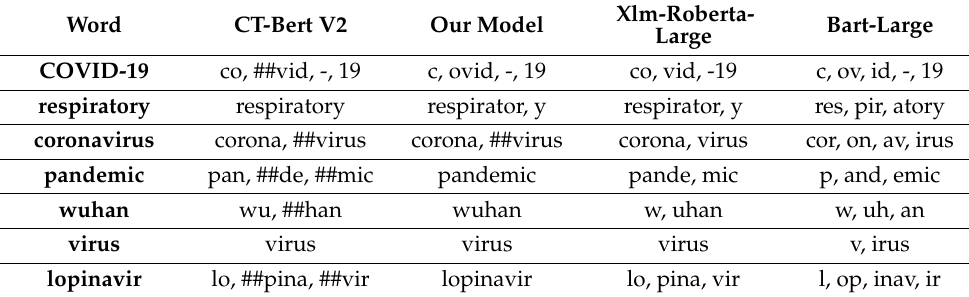
Table 13. Example of Tokenized output from all